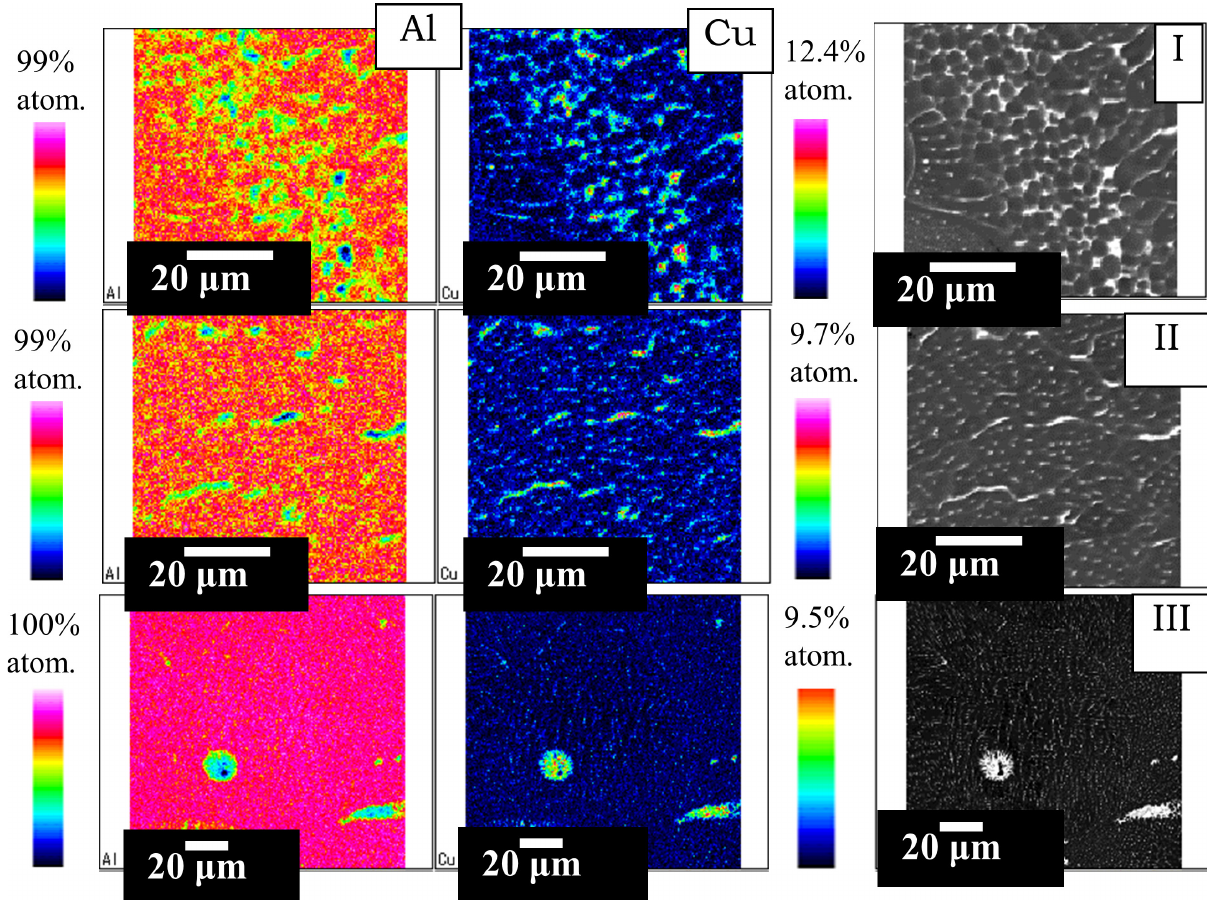
Figure 6: EPMA maps of Al and Cu (Left and middle) and BSE images (Right) of Area I, II and